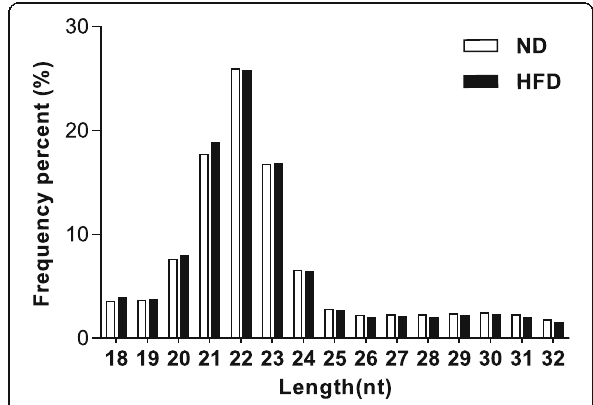
Fig. 2 The length-frequency distribution of clean reads in ND and HFD libraries. ND, normal diet mice; HFD, high-fat diet